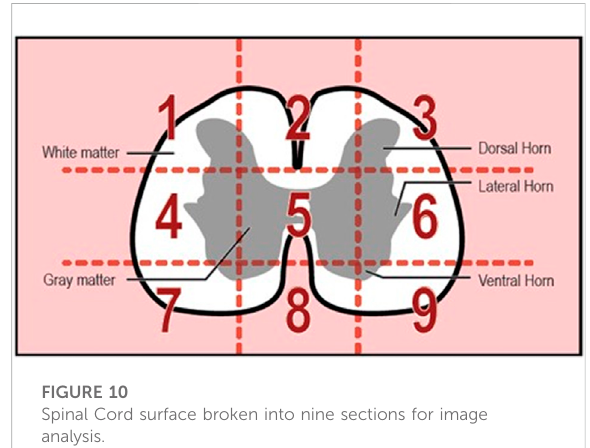
FIGURE 10 Spinal Cord surface broken into nine sections for image